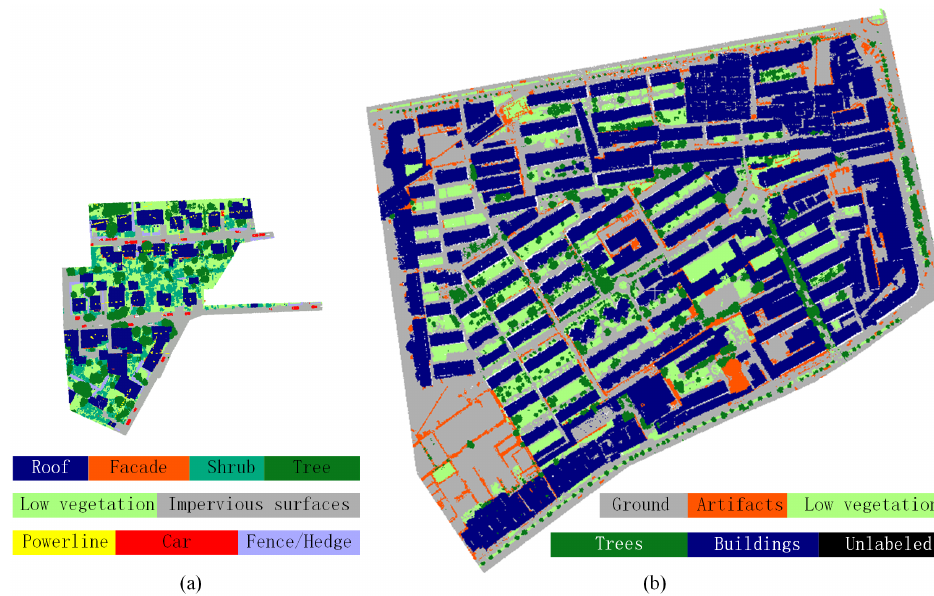
Figure 11. Comparison of building distributions in ( a ) Vaihingen and ( b ) LASDU